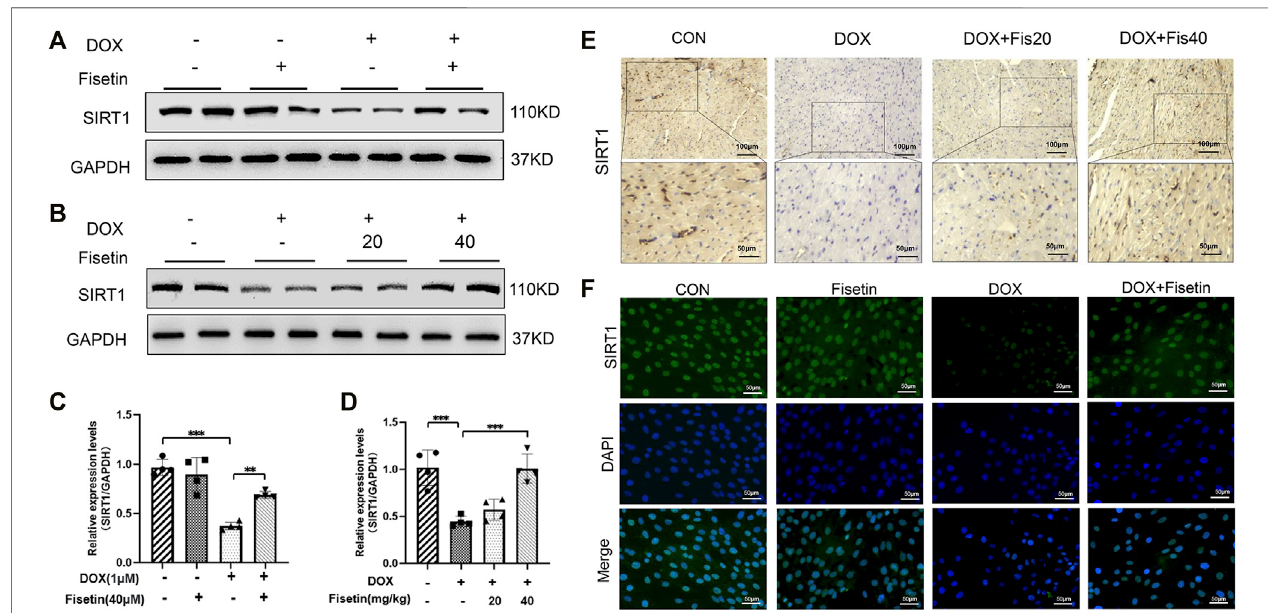
FIGURE6 | Fisetin attenuates ferroptosis via upregulating theSIRT1 protein expression inDOX-treated rats and H9c2 cells. (A) . SIRT1 protein expression levels in rats, asmeasuredbyWesternblot. (B) .Western blotresultsofSIRT1 levels invitro . (C-D). Quanti fi cation of (Aand B) . (E) .Representativeimages ofanti-SIRT1 staining byIHCindifferentgroups(200X and400X,Scalebar=100and 50 μ m, n =6per group). (F) .Representativeimagesofanti-SIRT1IFstaining(200X,Scalebar =50 μ m). The values are presented as mean ± SD. ** p < 0.01; *** p < 0.001; SIRT1, Sirtuin 1.